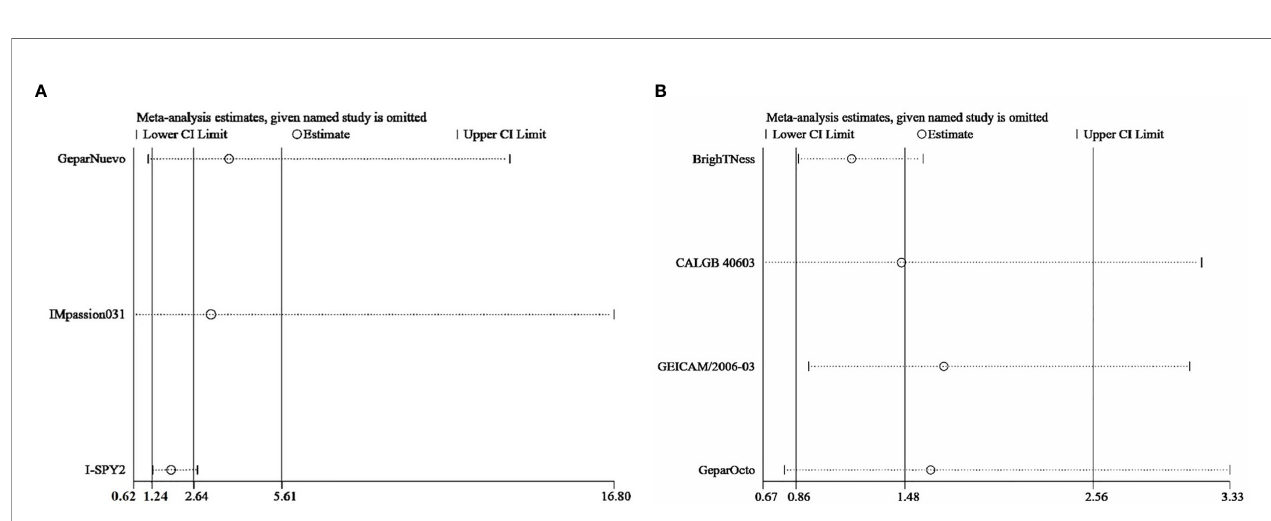
FIGURE 5 | Sensitivity analysis comparing the incidence of pCR in patients receiving ICIs vs AT-based NACT (A) and platinum vs AT-based NACT (B) .